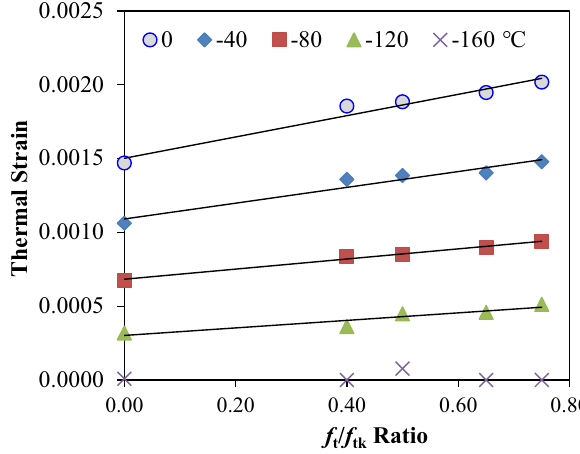
Fig. 4 Prestressing level versus thermal strain relationship during heating